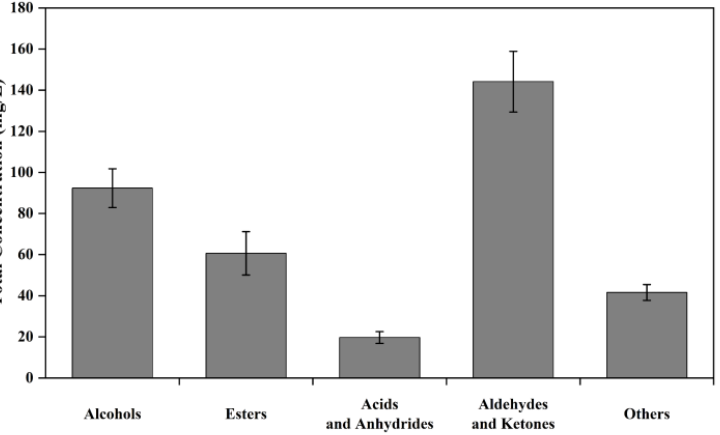
Figure 4. Total concentration of the volatile compounds of the waste sample. The data are shown as the mean values of three determinations (n = 3) ± standard deviation (error